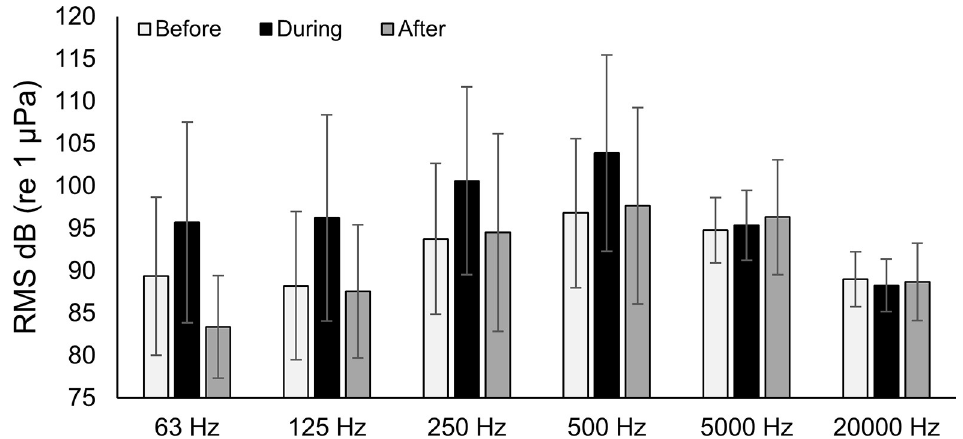
Fig 4. Boca 3 mean RMS sound pressure levels. Mean RMS sound pressure level at station Boca 3 (inshore) third- octave bands for before, during and after the passage of Tropical Storm Debby. Error bars ± 1 SD.